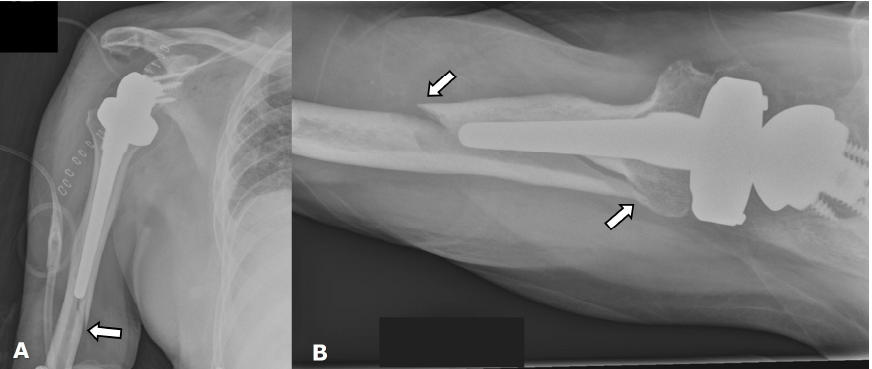
Figure 17. ( A ). Frontal radiograph in a patient immediately post-operative from RTSA shows a periprosthetic humeral fracture (arrow). ( B ). Axillary radiograph in a different patient with RTSA shows a periprosthetic fracture along the humeral stem (arrows). shows a periprosthetic fracture along the humeral stem (arrows).